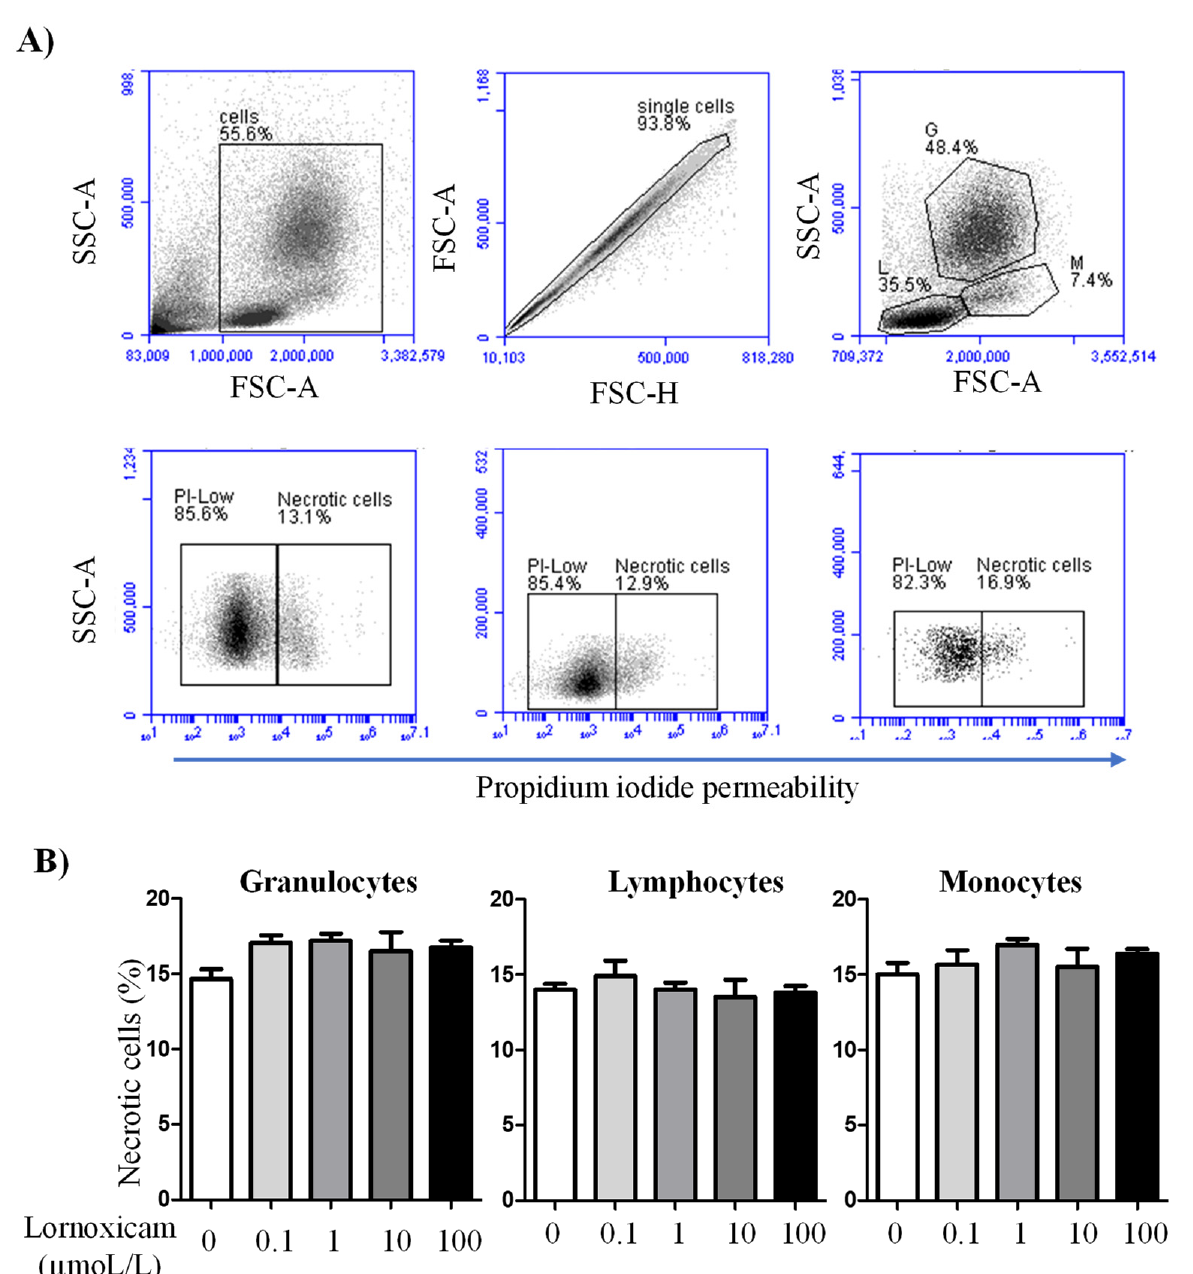
Figure 6. The impact of in vitro incubation with lornoxicam on camel leukocytes cell necrosis. Leukocytes were labeled with propidium iodide (PI) and PI-uptake versus exclusion was measured by flow cytometry. ( A ) Gating strategy for the measurement of leukocytes cell necrosis. In a FSC-A/SSC-A density plot, cell debris was excluded by gating on leukocytes according to their FSC and SSC properties. Within singlets (as identified in a FSC-H/FSC-A density plot), granulocytes (G), lymphocytes (L), and monocytes (M) were gated according to the cell-specific FSC and SSC characteristics. Viable (PI low ) cells and necrotic (PI high cells) were identified in a SSC-A/PI density plot. ( B ) The percentages of necrotic cells within the whole population of granulocytes, lymphocytes, and monocytes were presented as mean ± SEM. The differences between the treatments were considered significant if the p value was less than 0.05 (one-way ANOVA; repeated